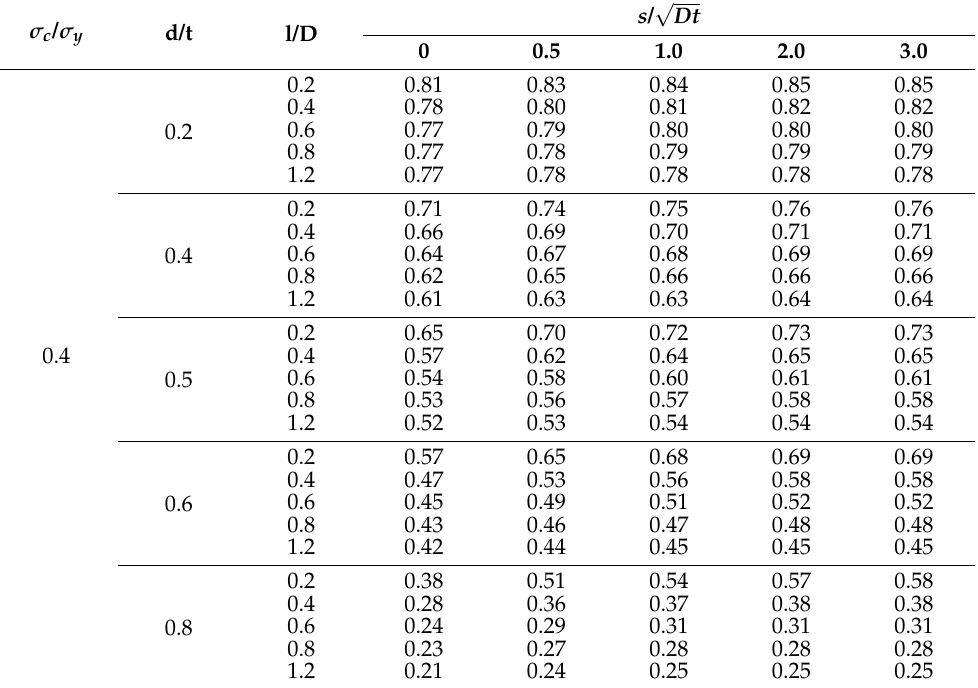
Table 7. FEA on corroded pipeline with LID subjected to internal pressure and 0.4 σ c / σ y longitudinal compressive